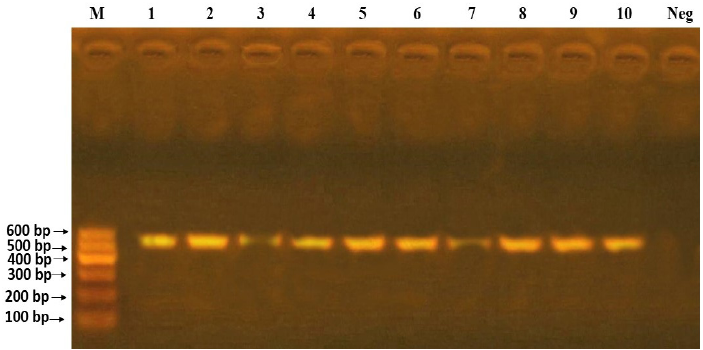
Figure 5. Agarose gel electrophoresis using ITS2 primers of the PCR product.